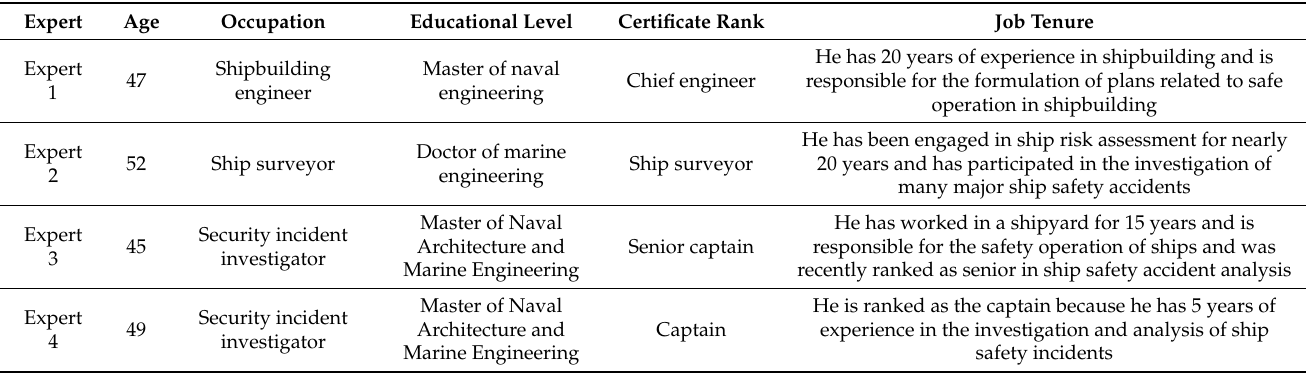
Table 3. Basic information for the experts employed in the present